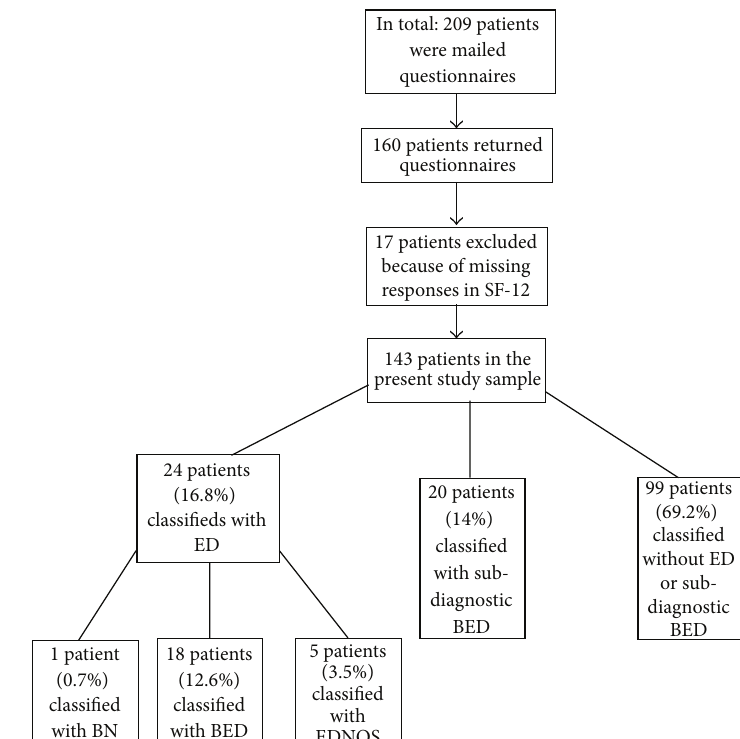
Figure 1: Flowchart for subject recruitment and eating disorder diagnosis in the present